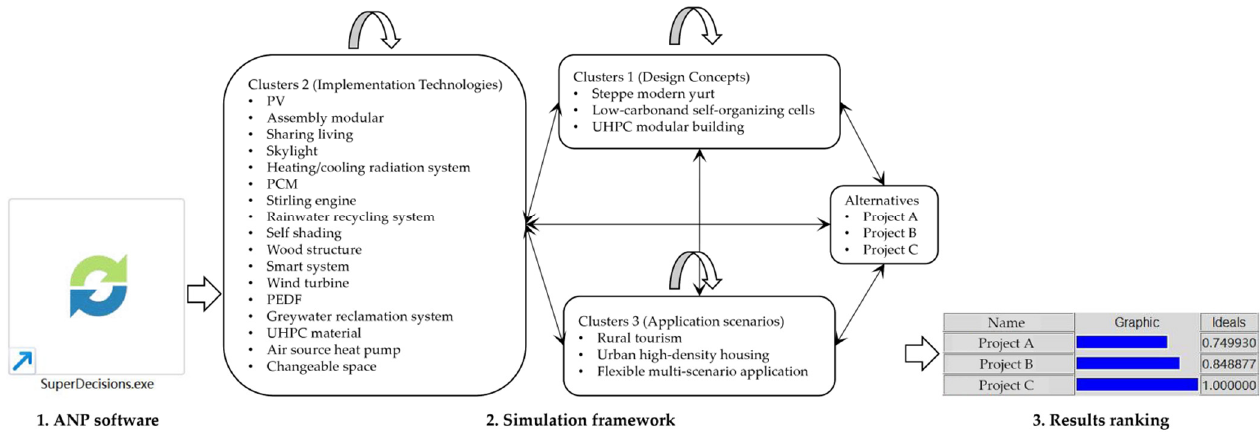
Figure 19. Critical thinking of the ANP ranking method.